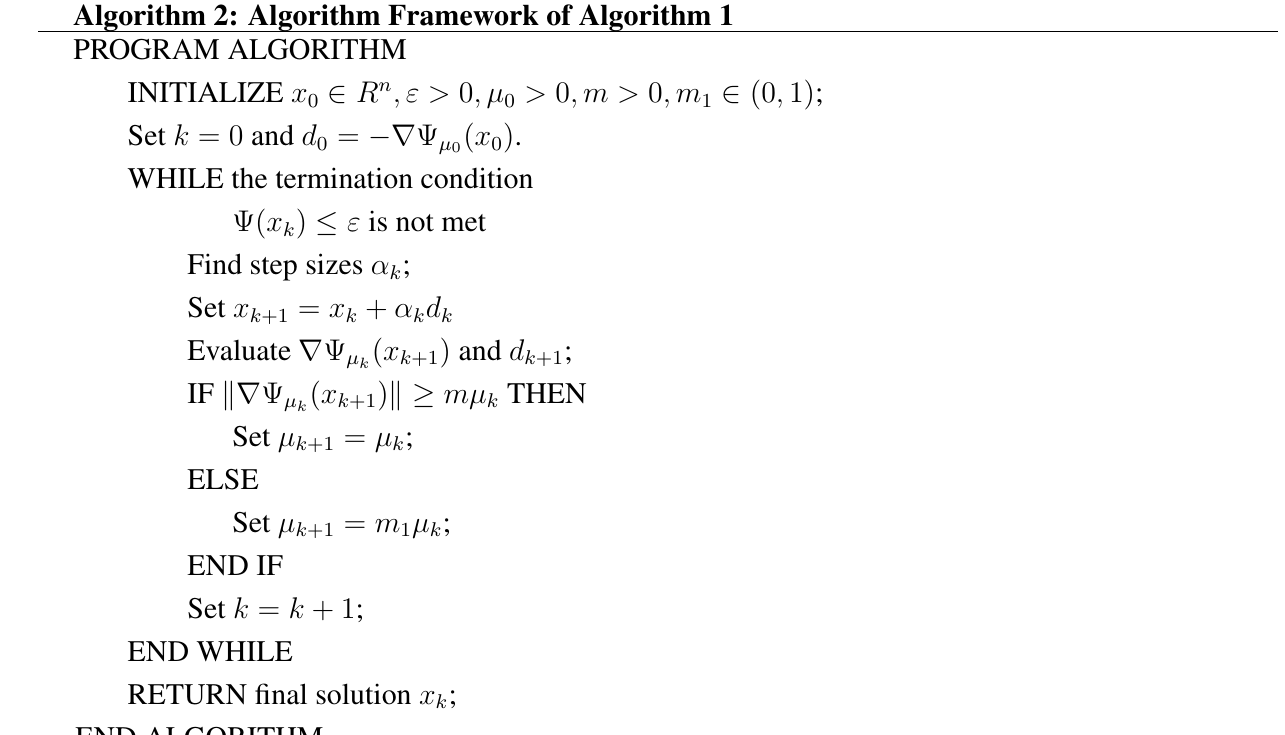
Algorithm 2: Algorithm Framework of Algorithm 1 PROGRAM